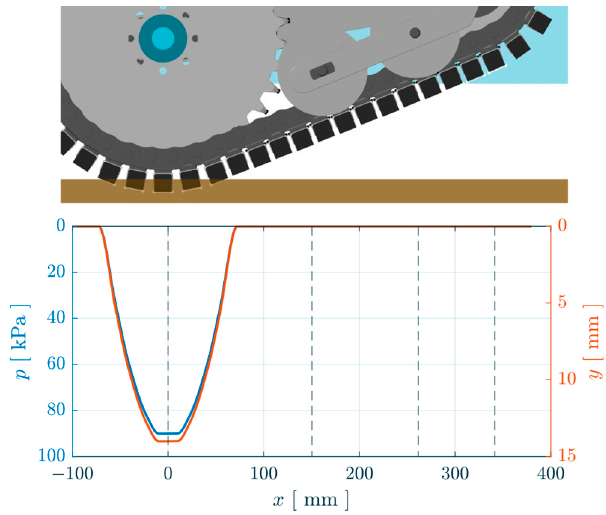
Figure 20. Normal pressure distribution (left y axis) and sinkage (right y axis) of the reconfigurable module in wheel mode.